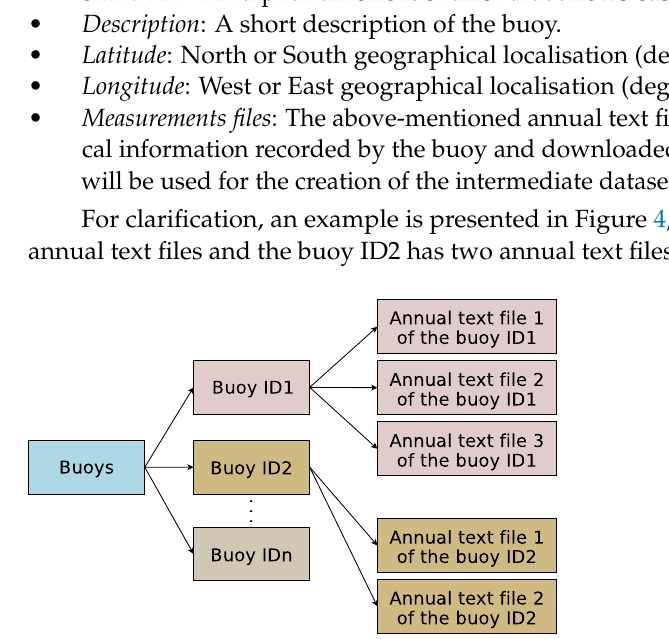
Figure 4. Example of entering two buoys with its annual text files.